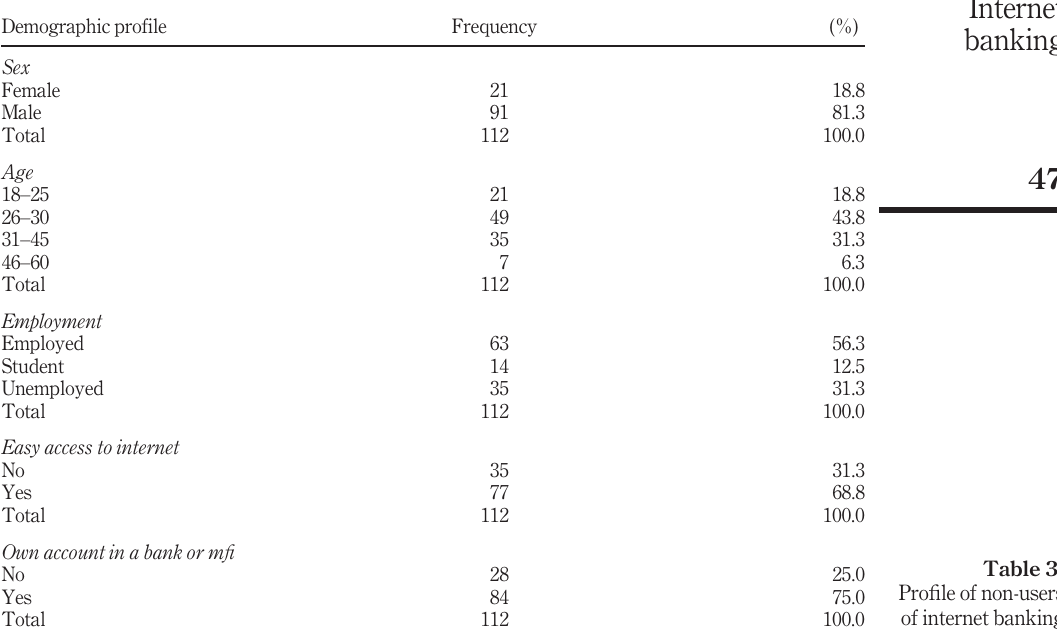
Table 3. Pro fi le of non-users of internet